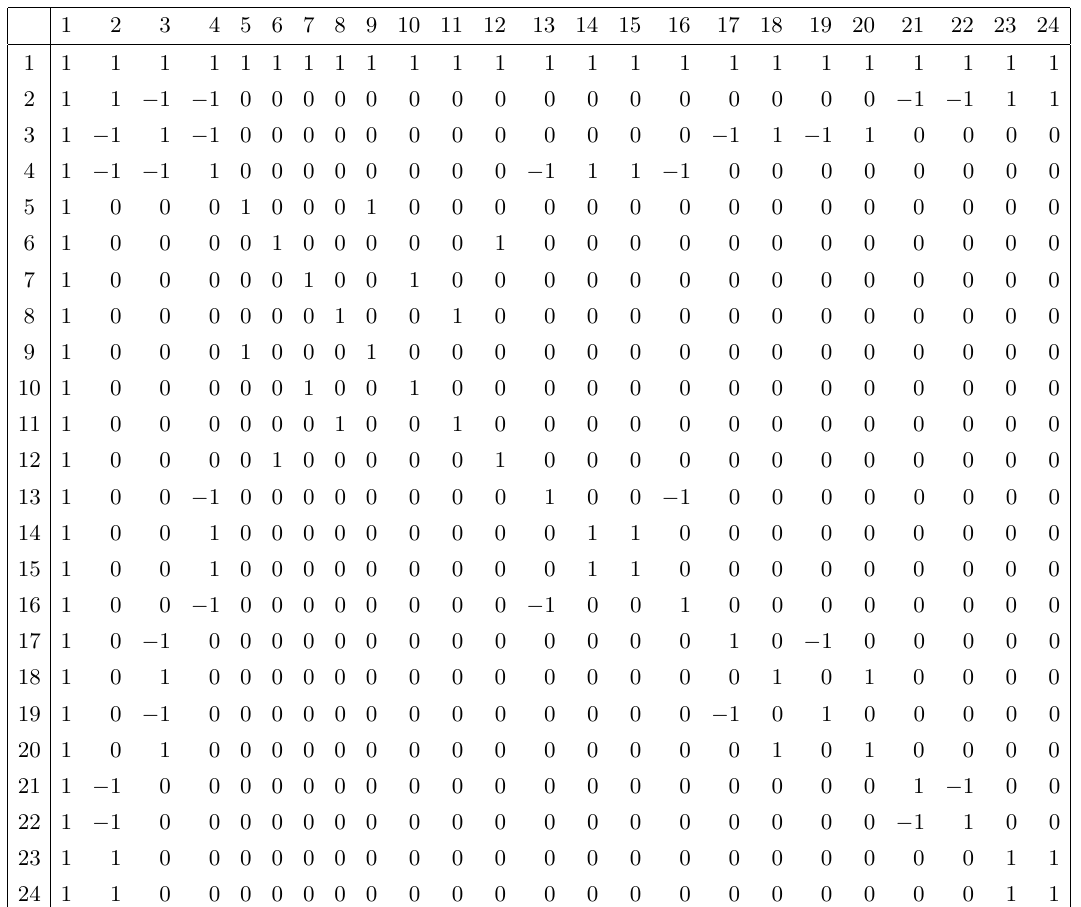
Table 12 . Twisted sector phases for discrete torsion in S 4 orbifold, derived from cocycle in table 11. A zero entry indicates a non-commuting pair of group elements. Transpositions corresponding to group element numbers are listed in table 13.